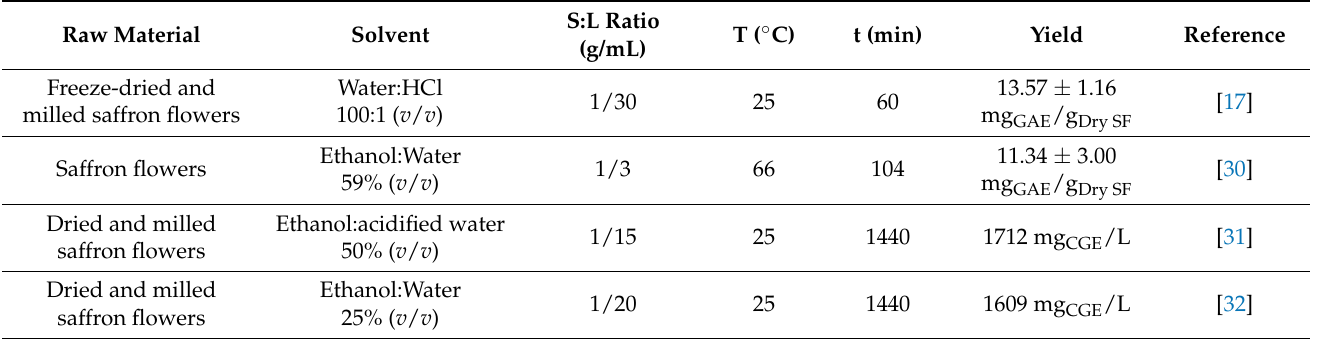
Table 2. Yields and optimum conditions of conventional solid–liquid extraction reported in the